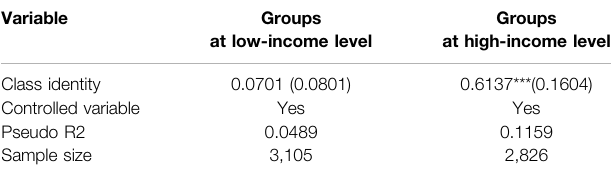
TABLE 4 | Estimated results for groups at different economic